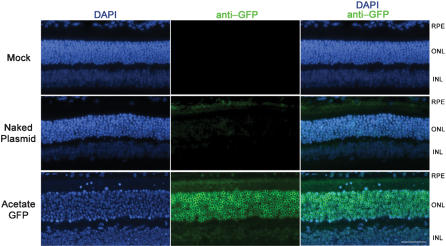
EGFP immunoreactivity following subretinal injection.To eliminate any artifacts due to retinal autofluorescence, immunohistochemistry was performed with a Cy-3-anti-GFP antibody on paraffin-embedded ocular sections from eyes taken at 2-days post-injection of 0.6 µg of compacted DNA.An absence of or minimal EGFP immunoreactivity was found in the mock-injected and naked plasmid-injected eyes, respectively.Examination of sections from eyes injected with the AC-GFP nanoparticle revealed high-level EGFP immunoreactivity in nearly all of the cells in the ONL.Lower levels of EGFP were also detected within the upper half of the INL.Scale bar, 10 µM.